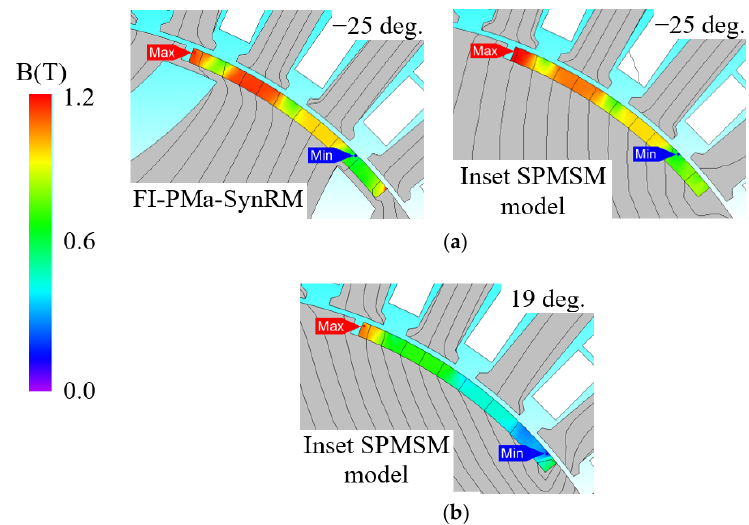
Figure 6. Compare PM flux densities distributions: ( a ) FI-PMa-SynRM and Inset SPMSM model at − 25 degrees; ( b ) Inset SPMSM model at 19 degrees.